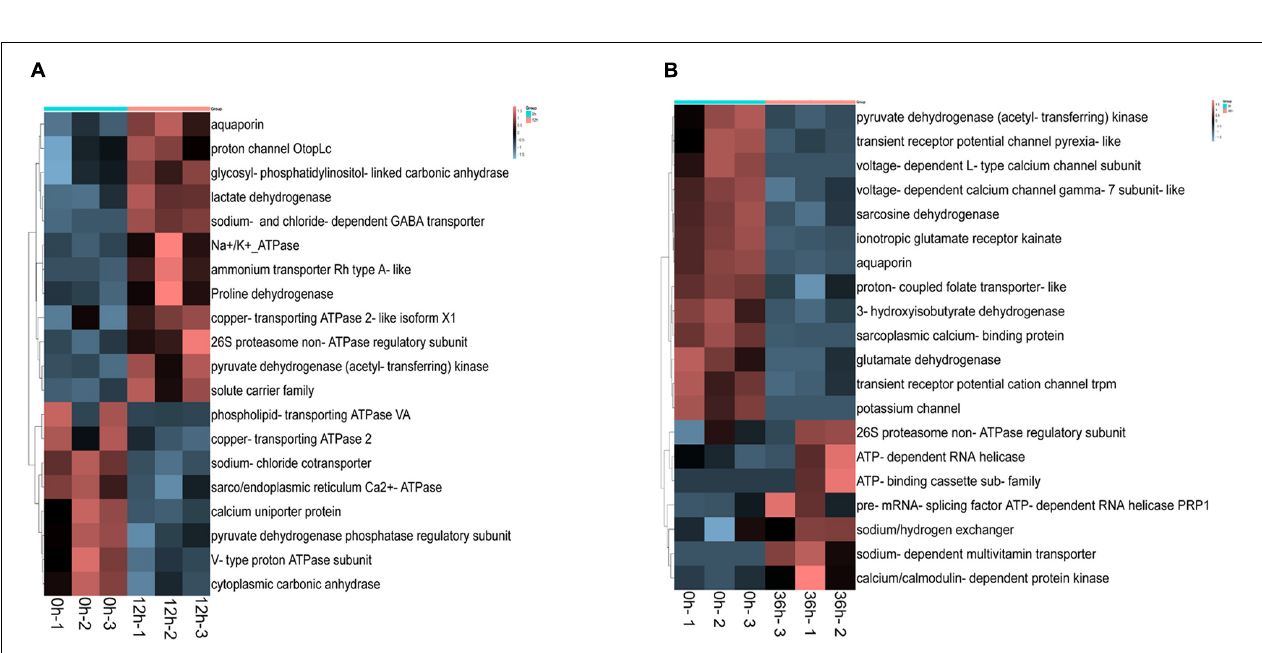
FIGURE 4 | Differentially expressed genes (DEGs) heat map of transcriptome associated with alkalinity stress. (A) Heat map of DEGs in 0 vs. 12 h. (B) Heat map of DEGs in 0 vs. 36 h.